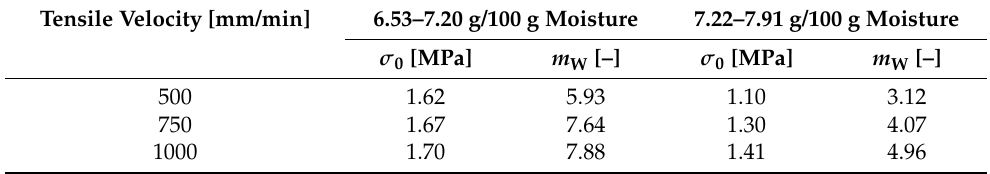
Figure 5. Weibull distribution probabilities P f ( σ ) based on caramel samples with low (6.53–7.20 g/ 100 g, left ) and high moisture content (7.22–7.91 g/100 g, right ). Stress on the abscissa refers to fracture stress σ f (open circles) or tensile strength R m (closed circles). Tensile velocity was v = 500 mm/min (blue), v = 750 mm/min (green) and v = 1000 mm/min (orange). Table 2. Effects of specimen length and tensile velocity on fracture properties ( T = 25 ◦ C). Tensile Velocity